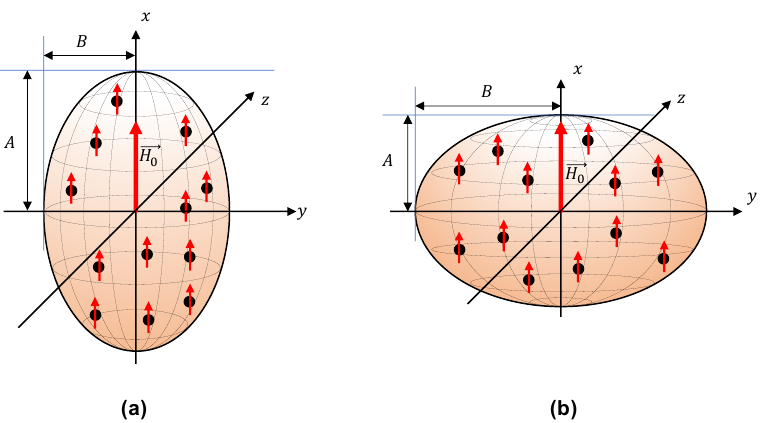
Figure 1. Schematics of an MAE sample with the shape of an ellipsoid of revolution with two equal semi axes B = C : ( a ) A prolate MAE sample ( A > B = C ). ( b ) An oblate MAE sample ( A < B = C